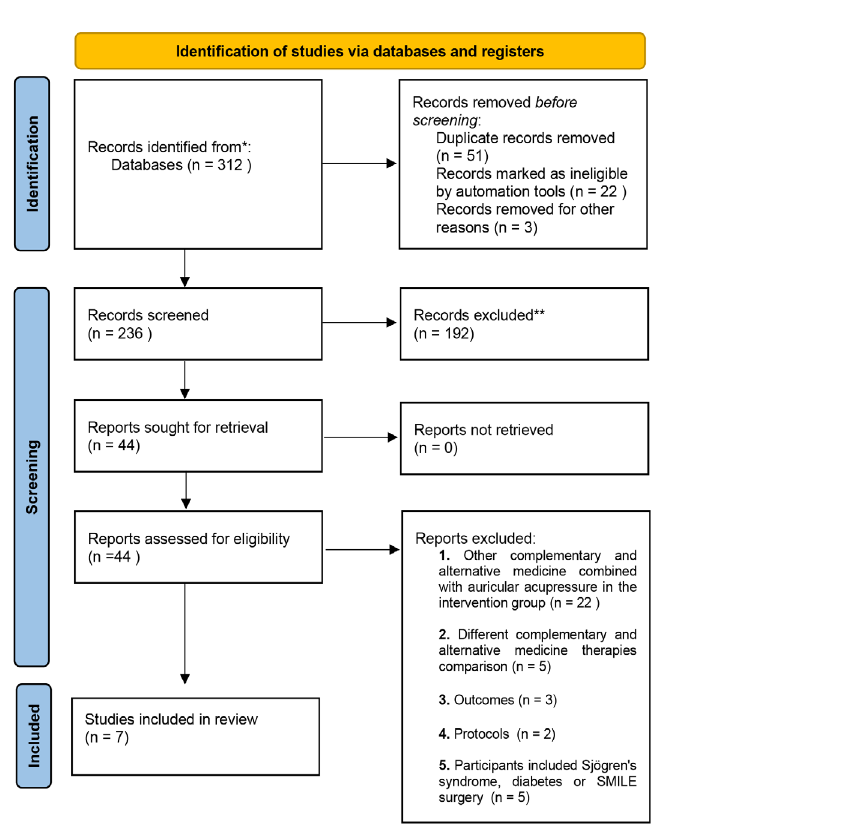
Figure 1. Flow diagram of the selection steps of the identified articles according to the PRISMA. * databases, ** how many records excluded.